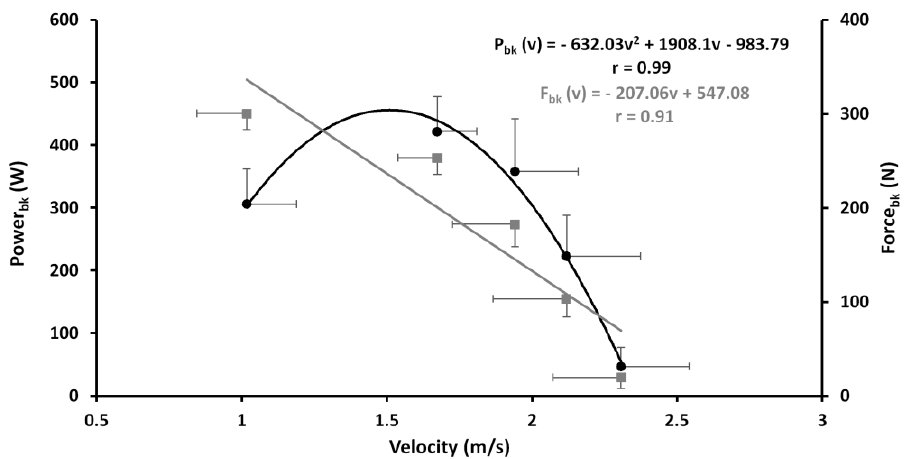
Figure 3. Linear F-v (grey line and squares) and second-order polynomial regression P-v (black line and dots) with the relative regression equations building on vertical thrust performed at incremental loads (from 5 to 25 kg). Both curves are depicted according the average and SD of velocity, force and power at different load as shown in Table 1.